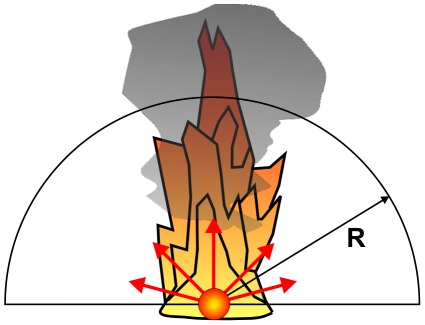
Point source model.